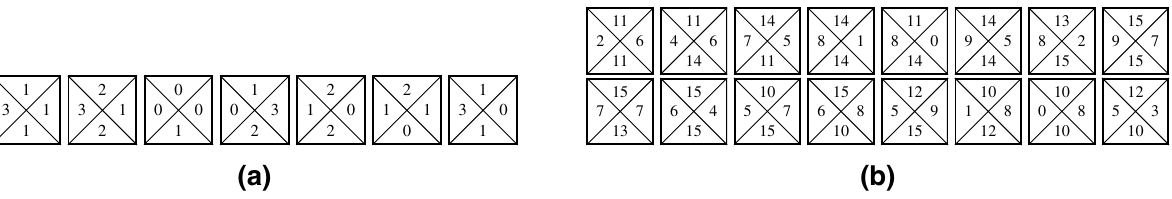
Figure 9. New tile sets ( a ) Finite1 of 7 tiles over 4 colors, and ( b ) Finite2 of 16 tiles over 16 colors used in our algorithmic